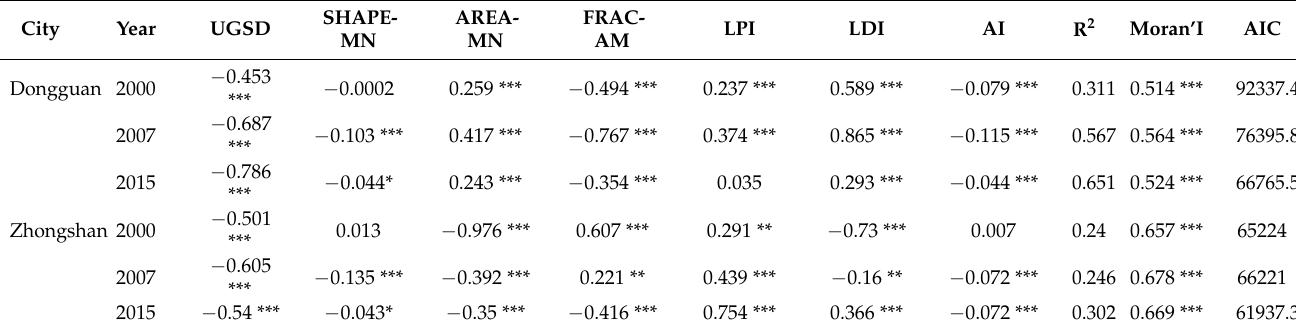
Table A4. The results by the SEM for the LST, the ISAD and the ISA landscape configuration metrics in different cities considered in this study from 2000 to 2015. * indicates p < 0.05; ** indicates p < 0.01; *** indicates p < 0.001.